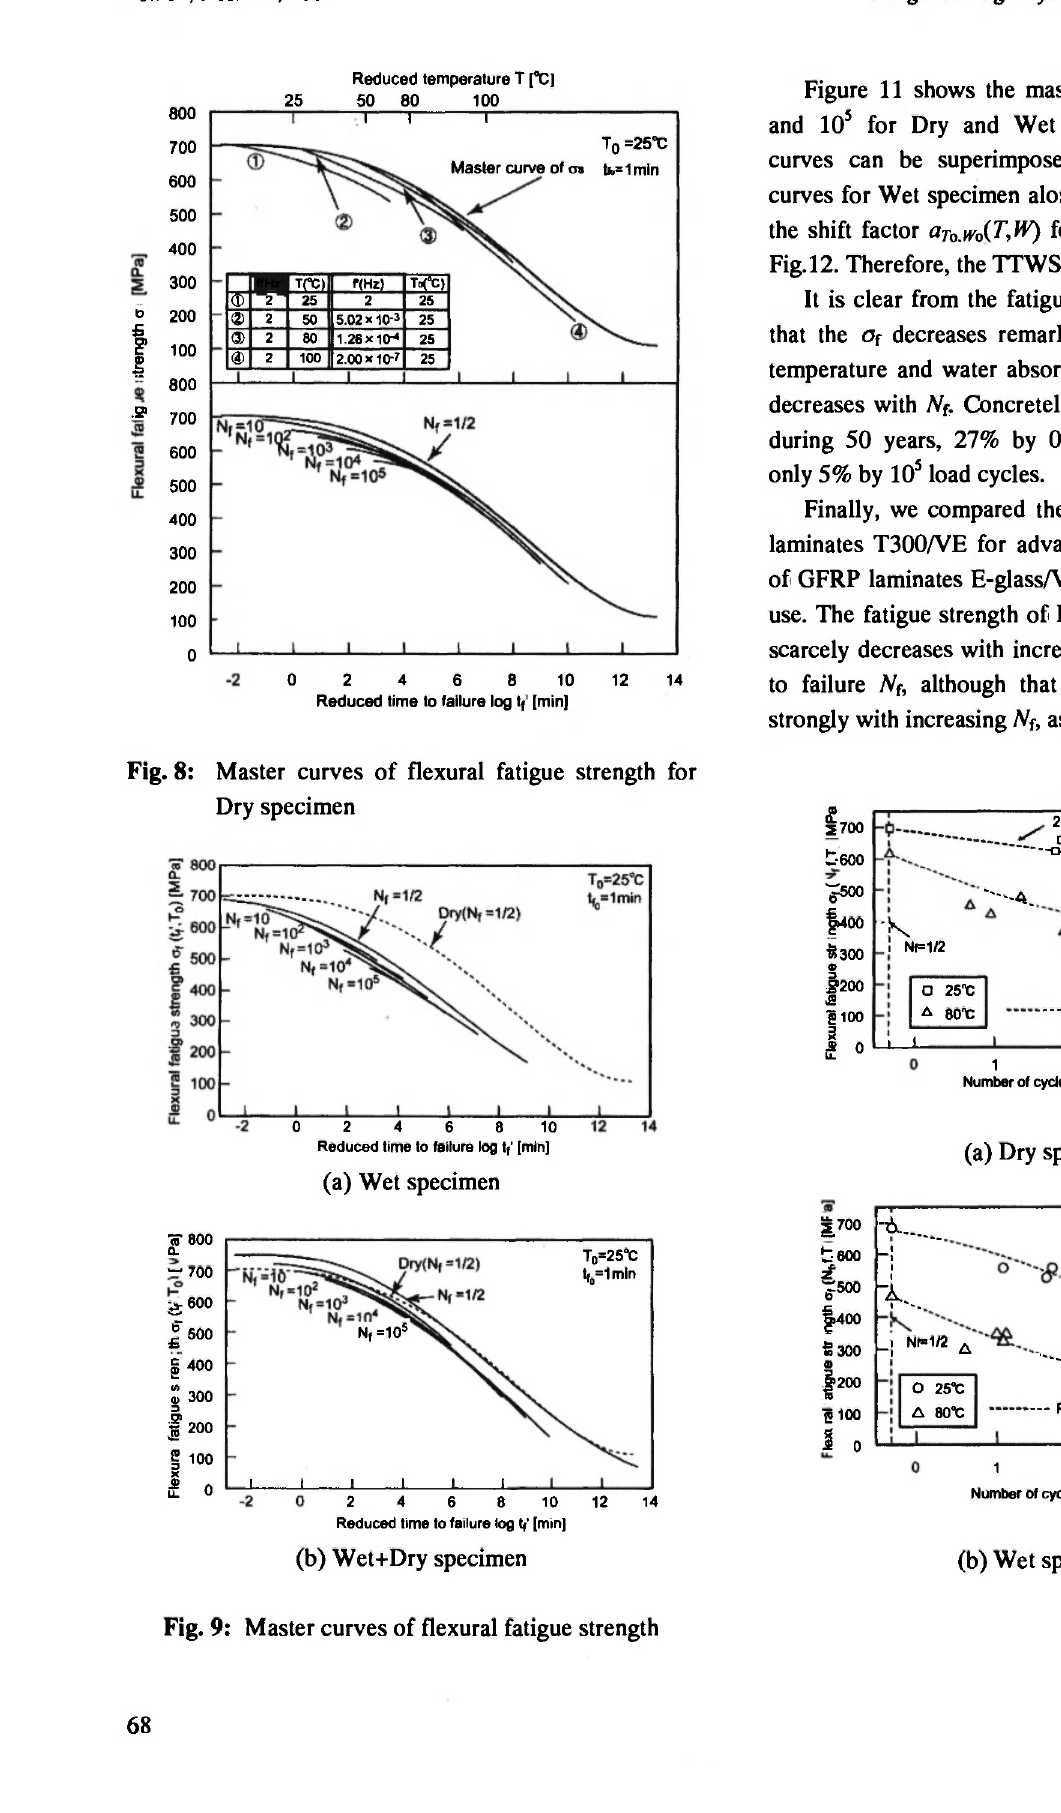
Fig. 9: Master curves of flexural fatigue